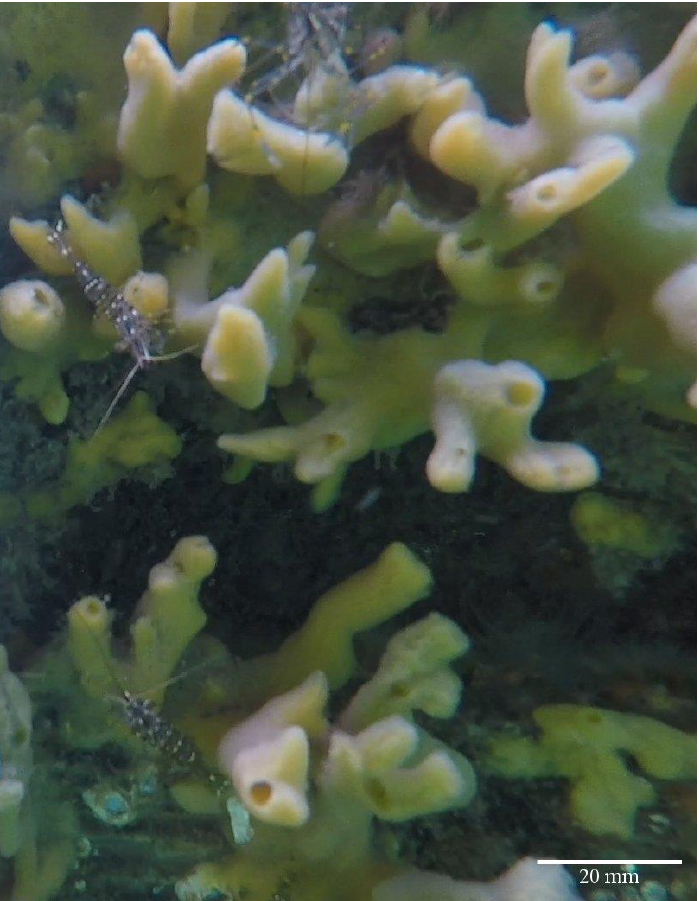
Figure 4. Halichondria panicea. Underwater photo (29 July 2019) from the inlet to Kerteminde Fjord, Denmark, showing erect branching (ramose) sponges of type (ii) with multi-modules each with an osculum.